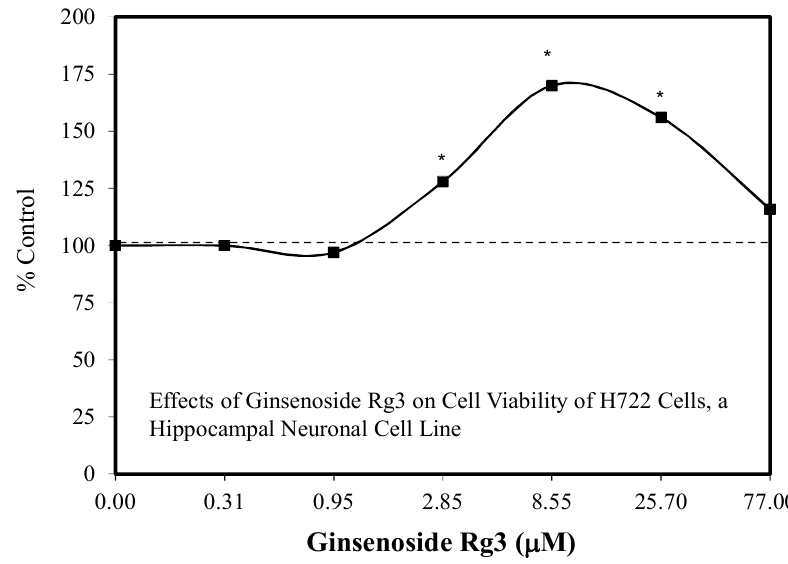
Figure 35. Effects of IP administration of Rg3 on the immunoinflammatory cytokines (IL-1B and cytokine 6) in adult male Sprague–Dawley Rats at 48 hours (source: [113]). Each * represent statistical significance for a data point.